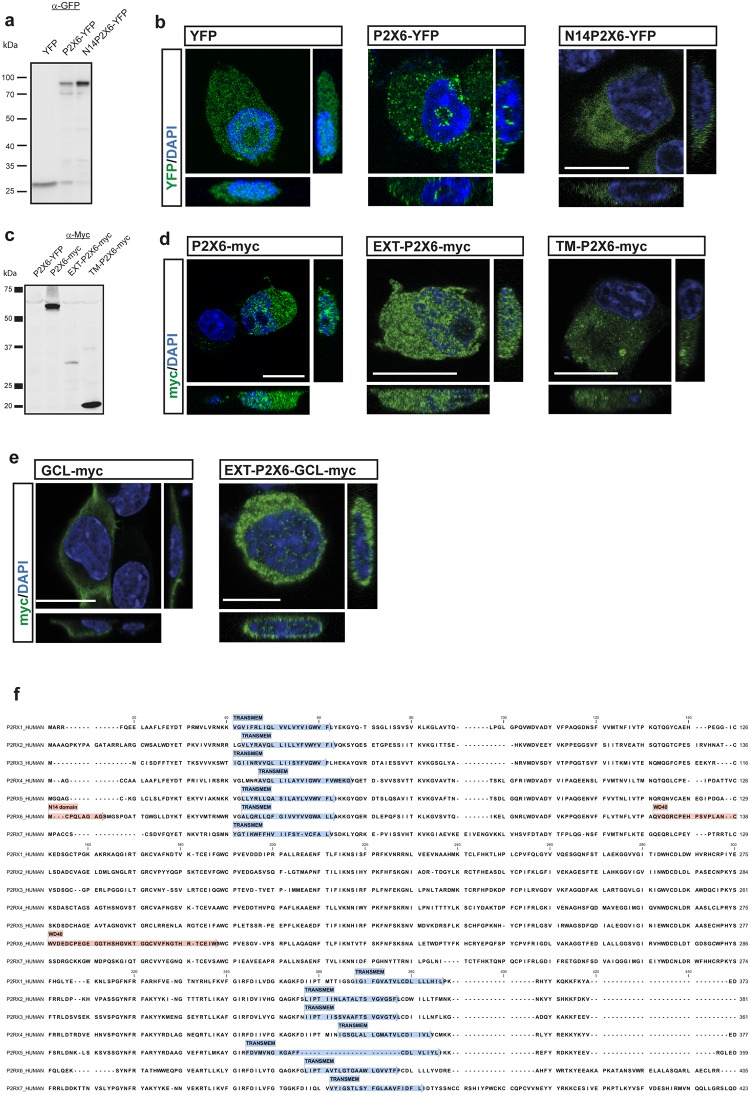
Extracellular region of P2X6 is responsible for nuclear location.(a) Western blot of protein extracts from neuroblastoma cells transfected with constructions containing YFP as control, P2X6 and N-terminal defective P2X6 fused with YFP (N14P2X6-YPF). (b) Confocal images and orthogonal views of N2a neuroblastoma cells transfected with YFP, P2X6-YFP and N14P2X6-YPF. Subcellular distribution of both YFP and N14P2X6-YFP were exclusively cytosolic, whereas P2X6-YFP shows cytoplasmic and nuclear location. Scale Bar 10 μm. (c) Western blots of protein extracts from neuroblastoma cells transfected with constructions containing different P2X6 subregions fused with c-myc epitope and labelled with anti-myc antibody. (d) Confocal images and orthogonal views of N2a neuroblastoma cells transfected with P2X6-myc, P2X6 extracellular region (EXT-P2X6-myc), and second transmembrane domain (TM-P2X6-myc). Subcellular distribution of TM-P2X6-myc were exclusively cytosolic, whereas EXT-P2X6-myc shows cytoplasmic and nuclear location. Scale bar 10 μm. (e) Neuroblastoma cells transfected with GCL-myc and P2X6 extracellular domain fused with GCL-myc (EXT-P2X6-GCL-myc) constructions show different locations. Subcellular distribution GCL-myc were exclusively cytosolic, whereas EXT-P2X6-GCL-myc shows cytoplasmic and nuclear location. Scale bar 10 μM. (f) Protein alignment of human P2X subunits using ClustalX algorithm and sequence analysis by PFAM database of protein families revealed the presence of WD40 domain exclusively in P2X6 subunit.